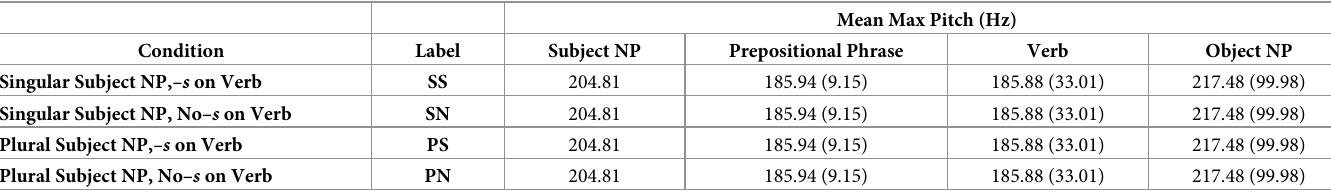
Table 2. Mean max pitch (Hz) for each phrase of the sentences tested in the auditory ERP experiment with their SDs (in